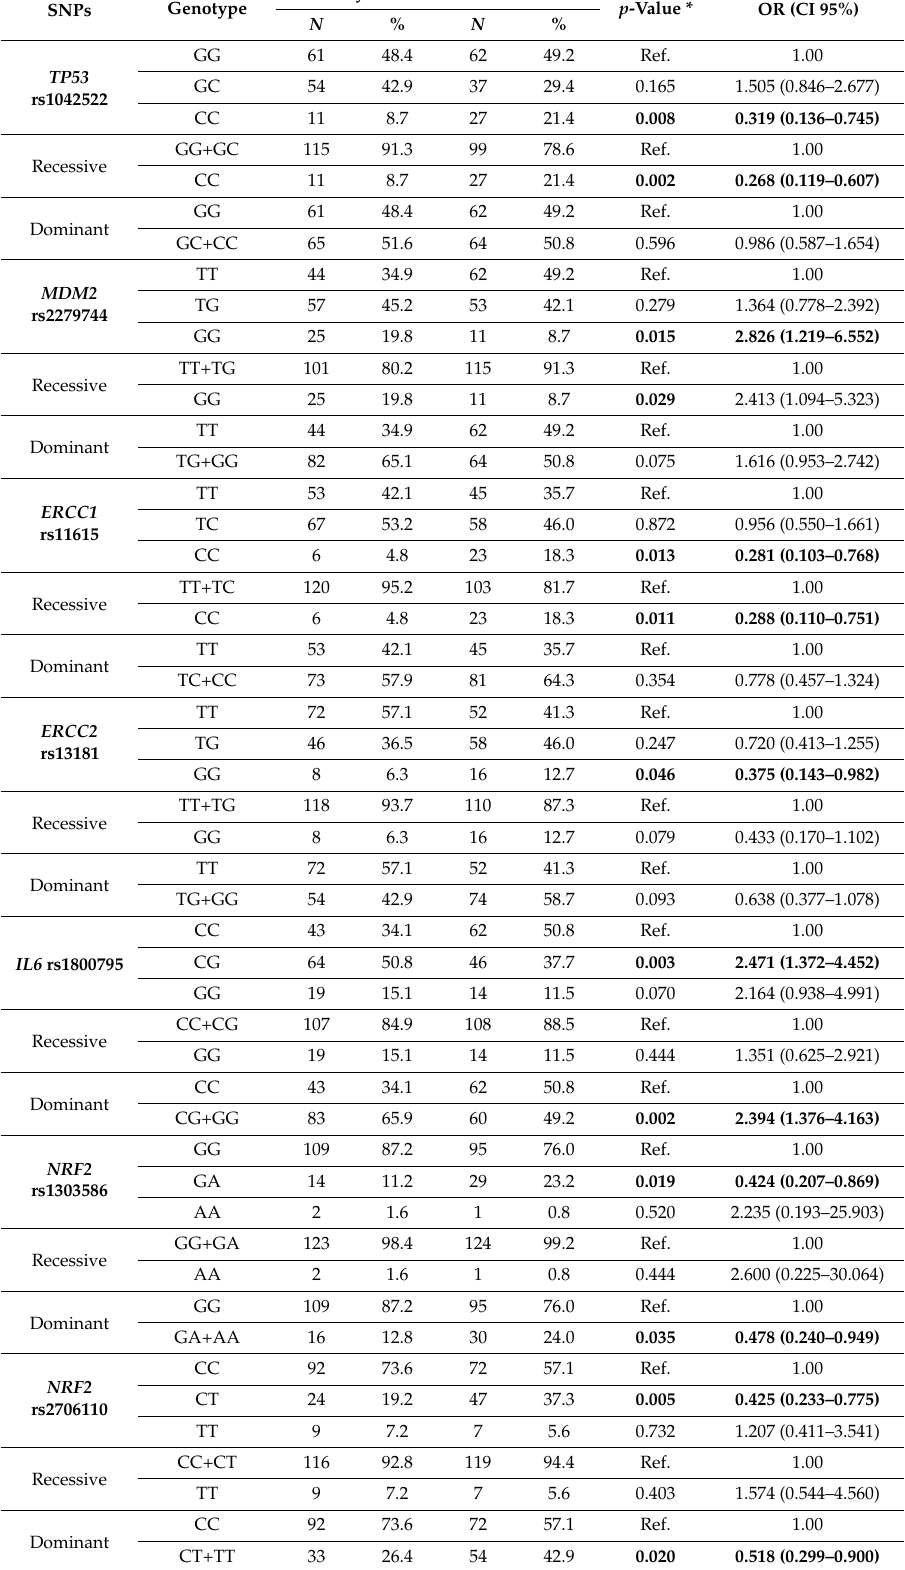
Table 2. Statistically significant SNPs in laryngeal